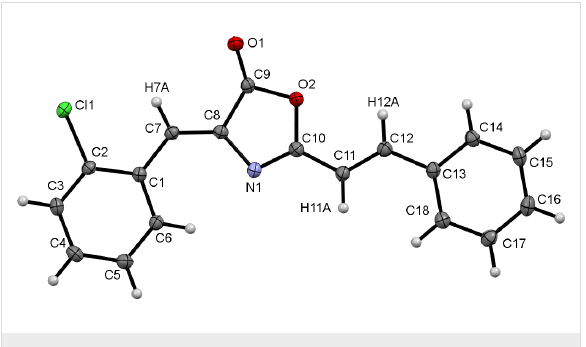
Figure 4: Molecular drawing of the oxazolone 2c